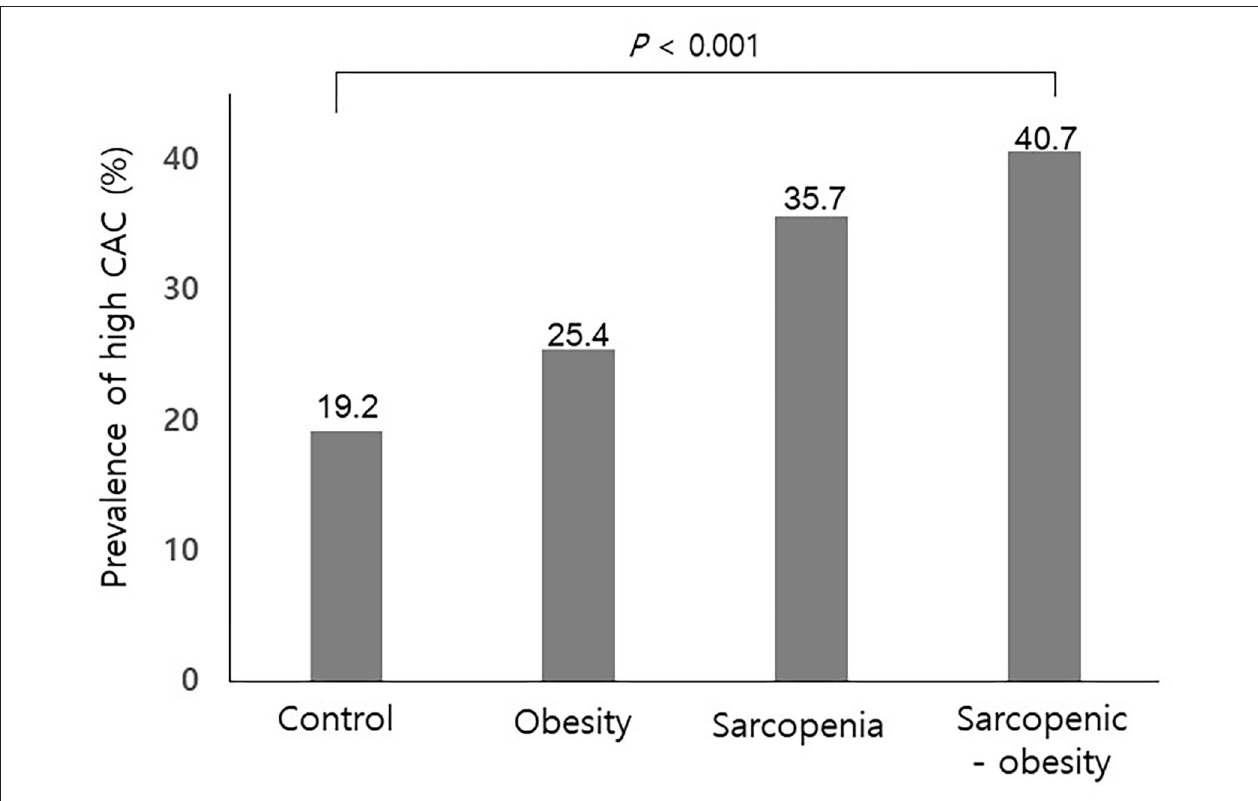
FIGURE 1 | Prevalence of a high coronary artery calcification score according to sarcopenia with or without obesity. CAC, coronary artery calcification. P for